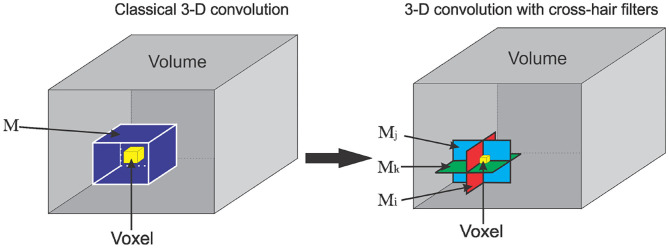
Graphical representation of cross-hair filters for 3-D convolutional operation. (Left) A classical 3-D convolution with filter M. (Right) Cross-hair 3-D convolutional with 2-D filter stack Mi, Mj, Mk.